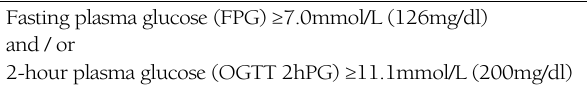
Medical Subject Headings (MeSH terms) and